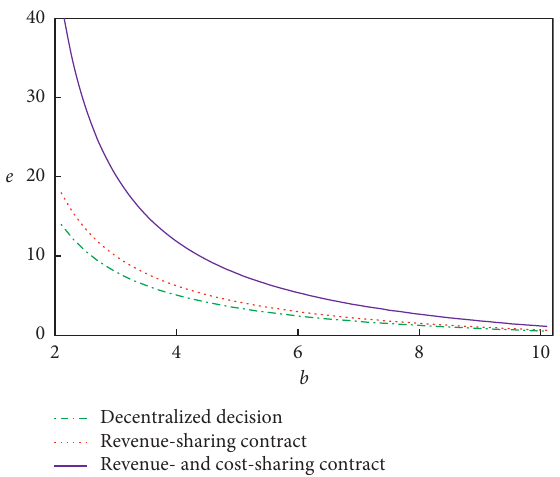
Figure 2: Impact of consumer price sensitivity factors on work safety levels.